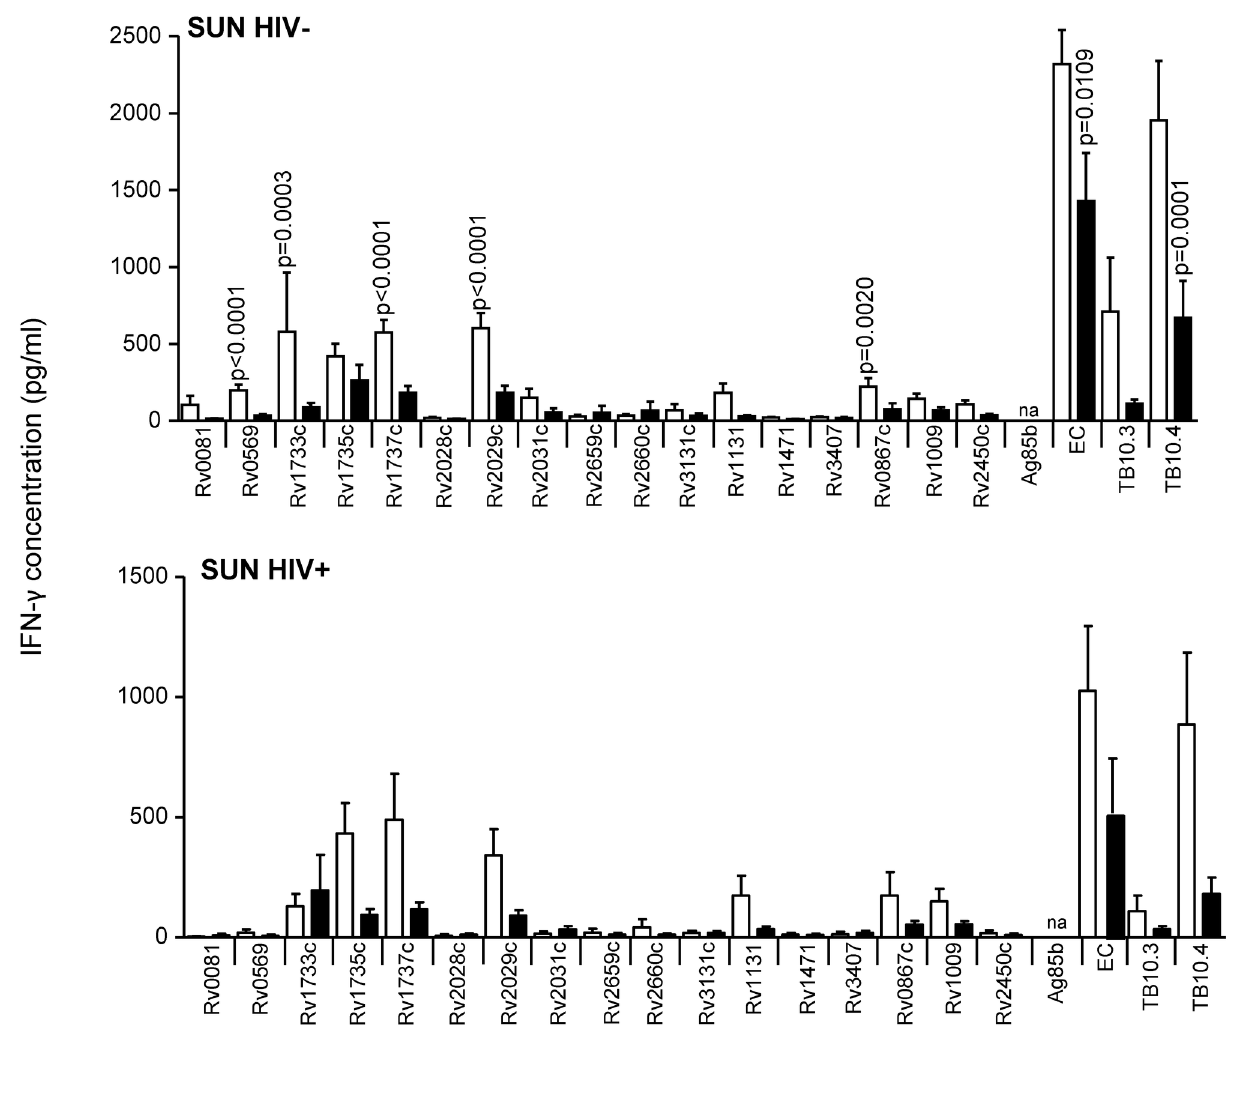
Figure 6. IFN-γ secretion in response to secreted, latent, and reactivation Mtb antigens in active TB and LTBI subjects, from South Africa. IFN-γ ELISA was performed on supernatants collected after 7-day antigen stimulation of diluted blood from TB cases (black) and TST + (LTBI) controls (white) from SUN (South Africa). Line indicates median, whiskers indicate 5–95% range and dots indicate outliers. Data were analysed by Mann-Whitney U-test for HIV – and/or HIV + subjects. Significant differences are indicated. n/d = antigen not